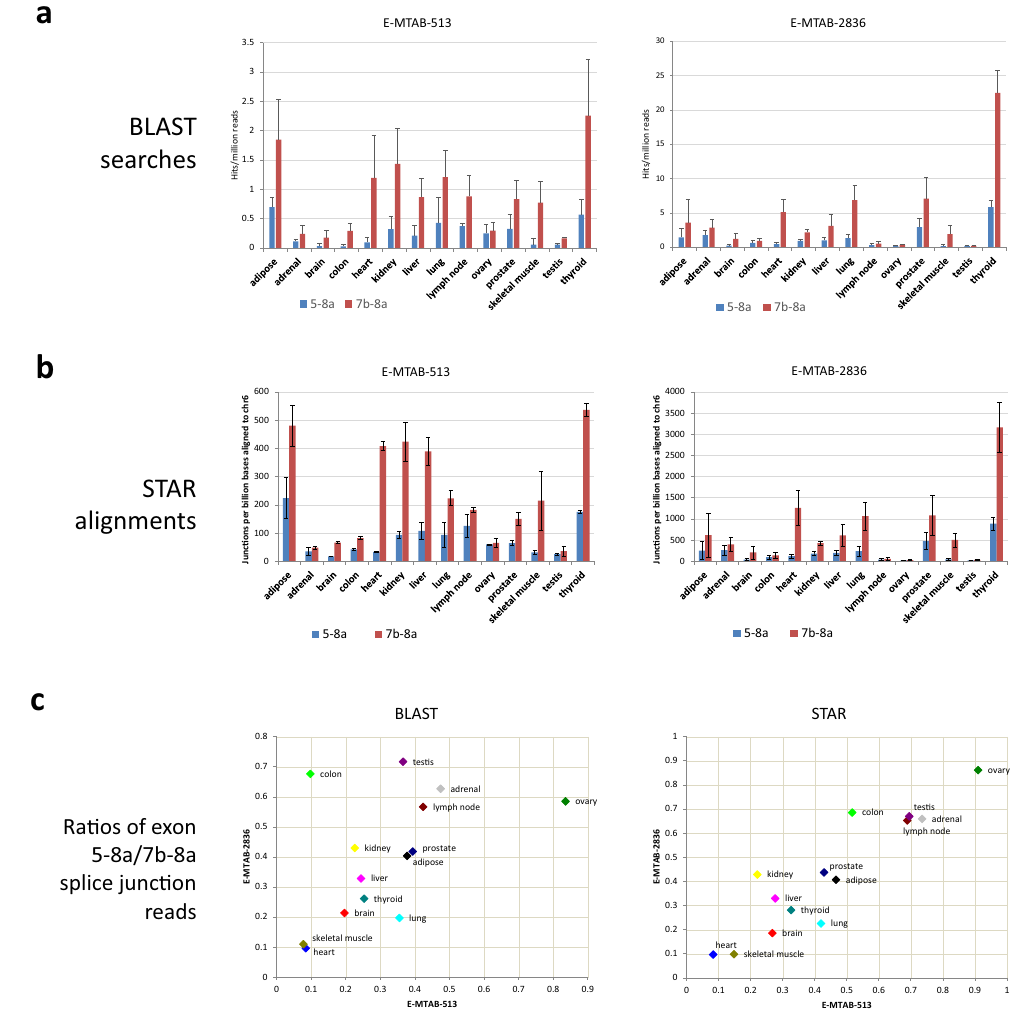
Figure 3. Occurrence of exon 8 splice junction sequences in RNA-Seq data from multiple tissues. Two multi- tissue RNA-Seq datasets (E-MTAB-513 and E-MTAB-2836) were interrogated for the presence of VEGFA exon 8 splice junctions. The number of reads reflecting splicing from exons 4, 6a and 7a were relatively few compared to those for the principal 5-8a and 7b-8a junctions (Supplementary Datasets 2 and 3). No sequences supporting the existence of the 8b site were detected. ( a ) The numbers of reads identified by BLAST searches to contain exon 5-8a and 7b-8a junction sequences are depicted across 14 tissues common to both datasets. ( b ) The number of exon 5-8a and 7b-8a splice junctions detected per billion bases aligned using the STAR aligner across the 14 common tissues. ( c ) The ratios of reads reflecting exon 5-8a: exon 7b-8a splice junctions for each tissue are plotted against the same tissue in the independent dataset. Both BLAST analysis (left) or STAR alignment (right) demonstrate correlation, with R 2 values of 0.26 and 0.83 respectively. This demonstrates that specific tissues have characteristic VEGFA splicing patterns, with the abundance of transcripts containing exon 5-8a splicing relative to those with 7b-8a splicing ranging from